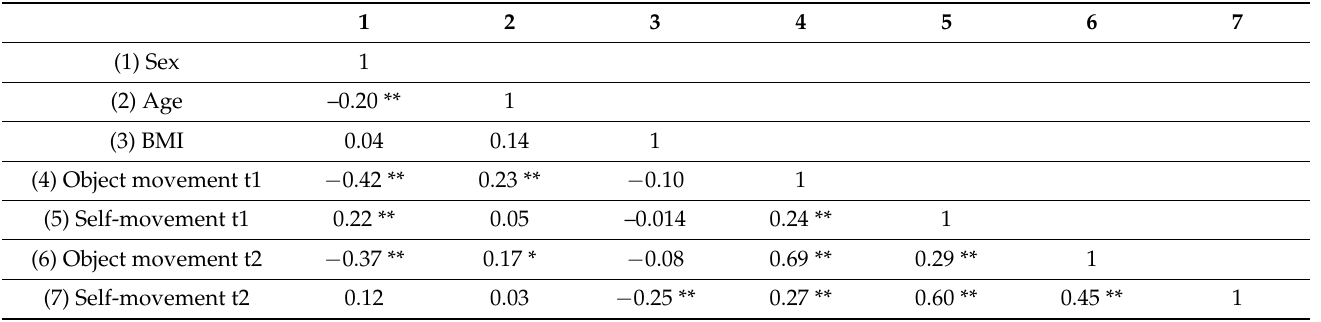
Table 4. Analysis of Pearson’s correlations between self-movement and object movement and sex, age,